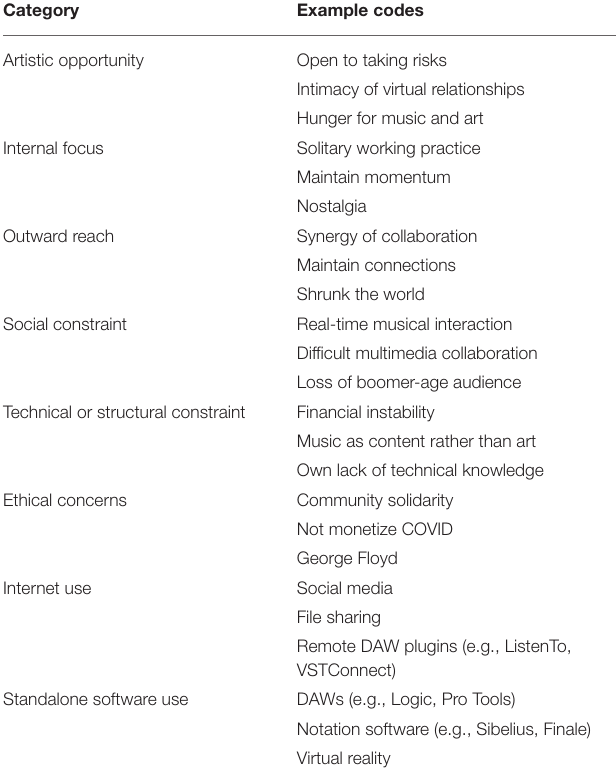
TABLE 6 | Categories and codes for interview analysis.